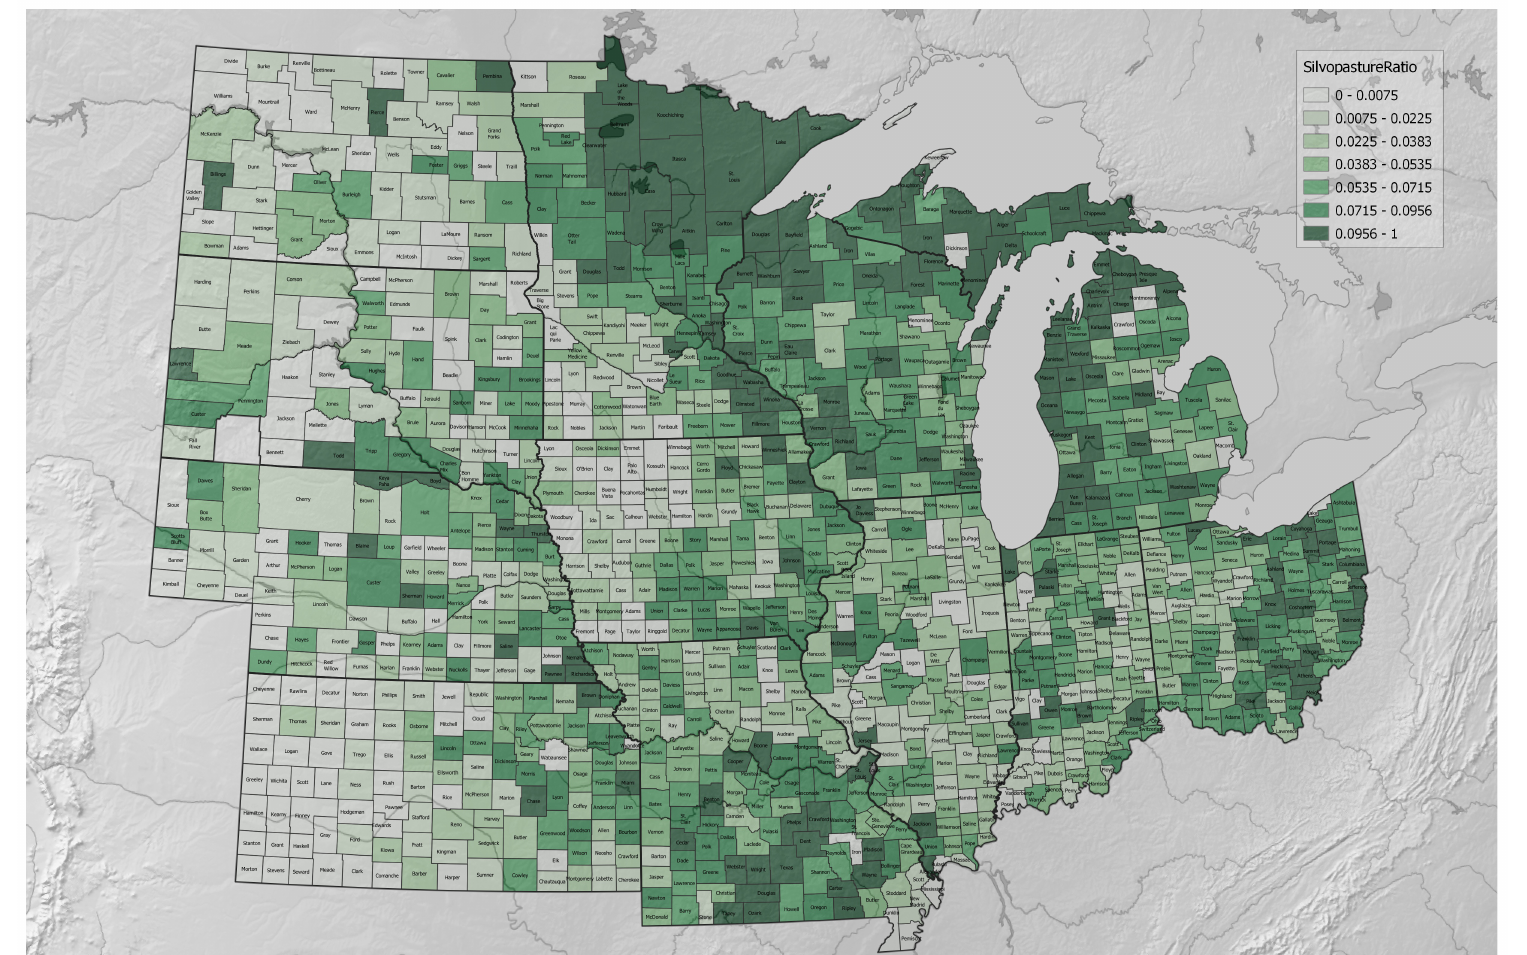
Figure A2. Fraction of farms practicing silvopasture, 2017. Values were all rescaled through dividing by the largest value present for any of the counties included here (0.219 in Cook County, Minnesota), as this transformation was applied to the variable data as they were placed into the index expression. Methods for SilvopastureRatio are described in the article main text and Supplementary Materials. USDA 2017 Census of Agriculture data [52] were